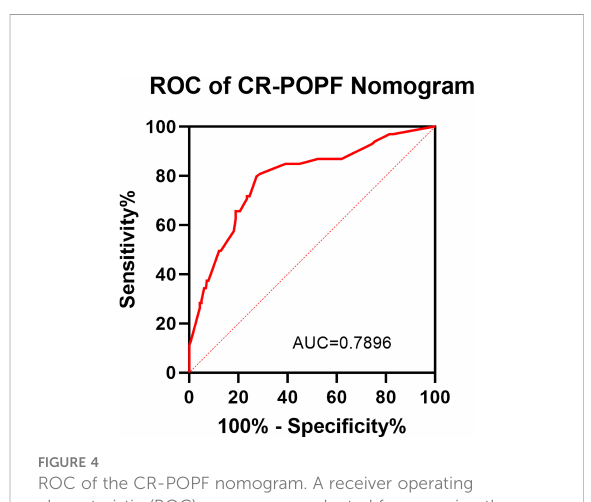
FIGURE 4 ROC of the CR-POPF nomogram. A receiver operating characteristic (ROC) curve was conducted for assessing the model. The area under the ROC curve is 0.7896.